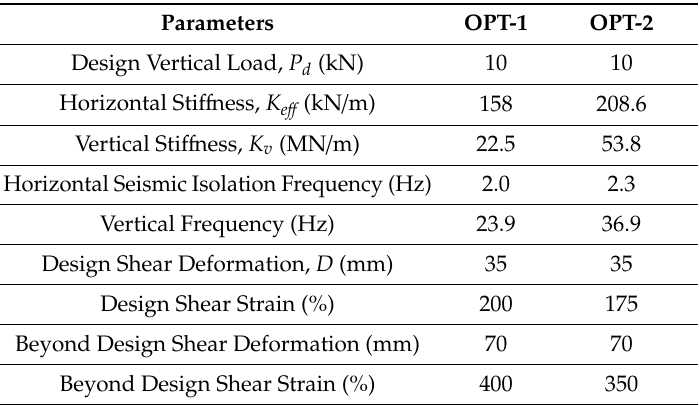
Table 3. Design performance